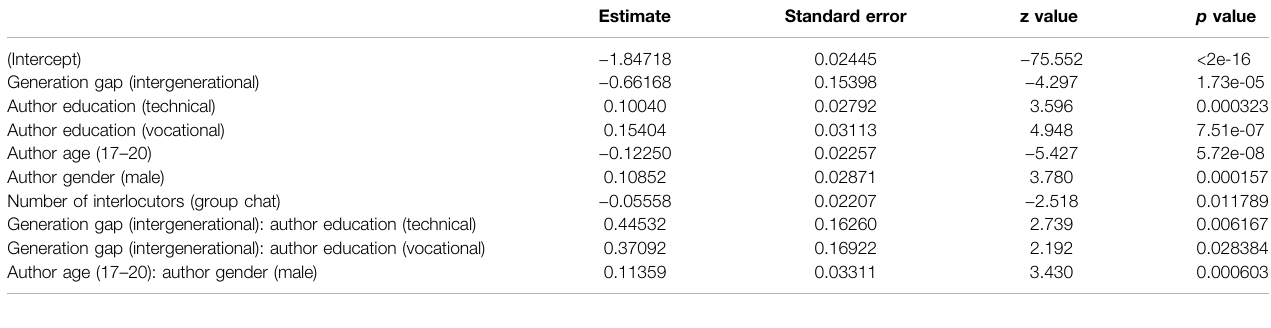
TABLE 5 | Orality: Fixed effects 10